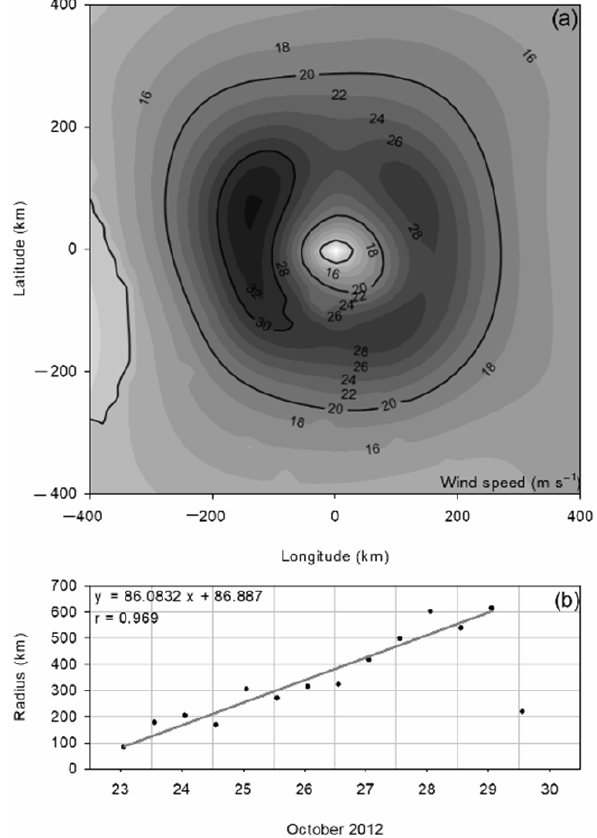
Figure 6. ( a ) Isotachs for 27 October 2012 at 1.30 UTC revealing the circular shape of some of them. ( b ) Evolution of the hurricane’s radius, assuming a circular shape for wind speed equal to, or higher than, that of a tropical storm. The linear increase was noticeable until 29 October 2012.